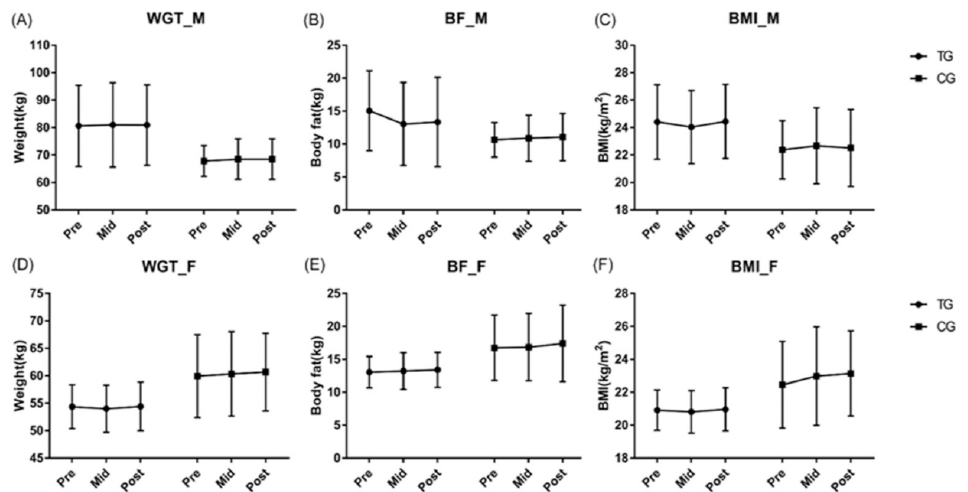
Figure 2. Effects of core balance training on body composition index. There was no effect of core training on body weight, WGT ( A , D ); body fat mass, BF ( B , E ); and BMI ( C , F ) in men and women. Abbreviations: WGT, body weight (kg); BF, body fat (kg); BMI, body mass index (kg/m 2 ); M, male group; F, female group; Pre, pre-test; Mid, mid-test; Post, post-test; TG, training group; CG, control